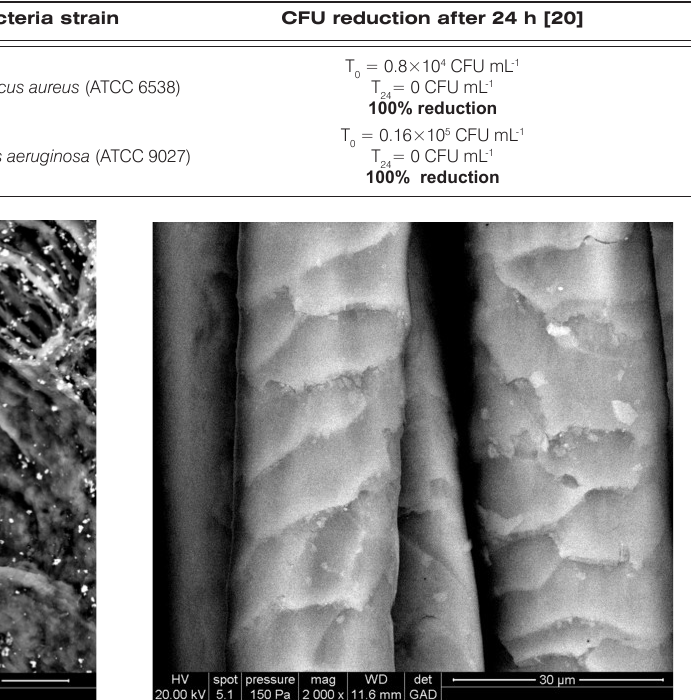
Figure 7. SEM image of AgNPs deposited onto keratin fibres of